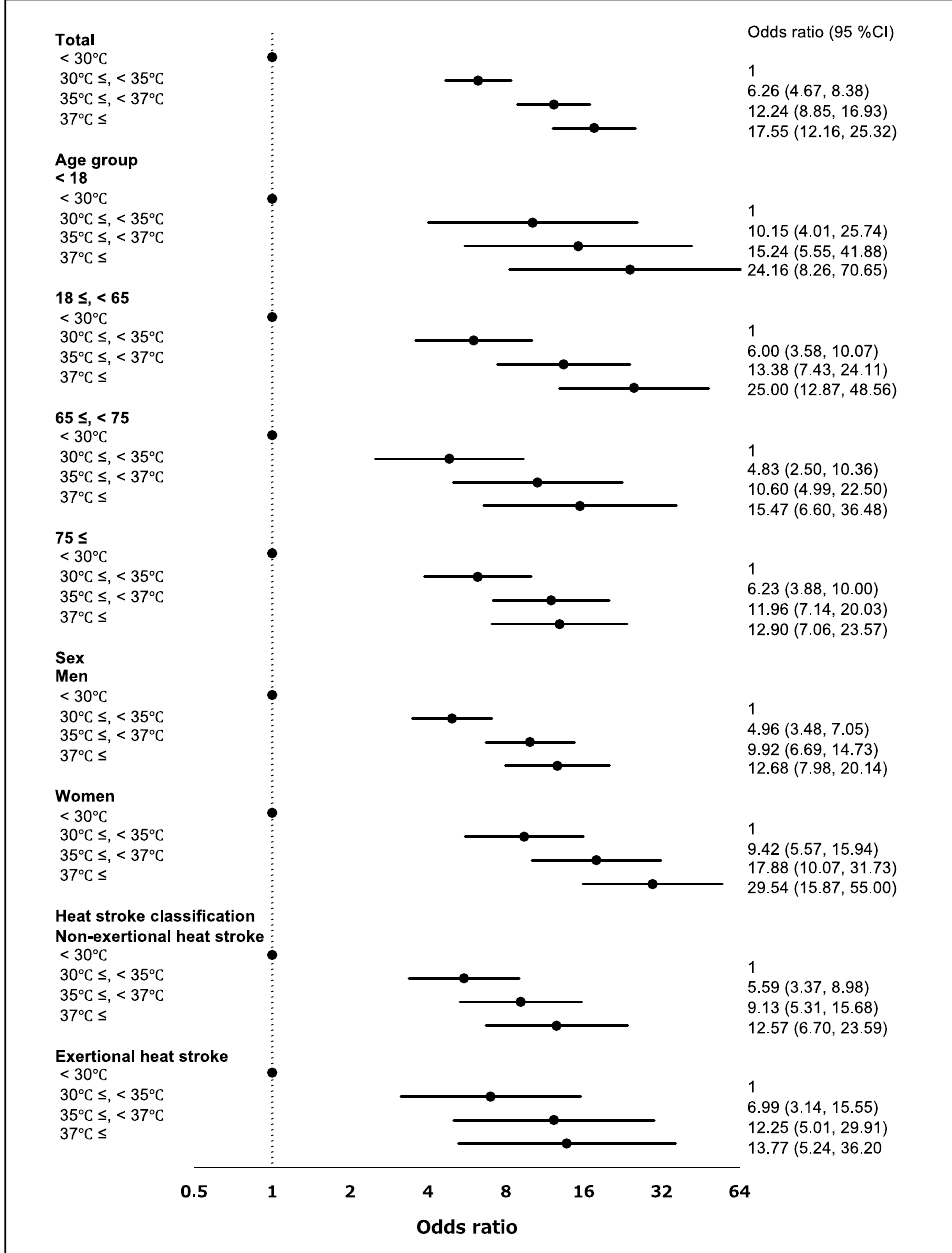
Figure 3. Risk of developing a heat stroke by maximum air temperature and stratified by age, sex and heat stroke classification. The black dots mean the odds ratio. Numbers in parentheses are the 95% confidence intervals (95% CI).